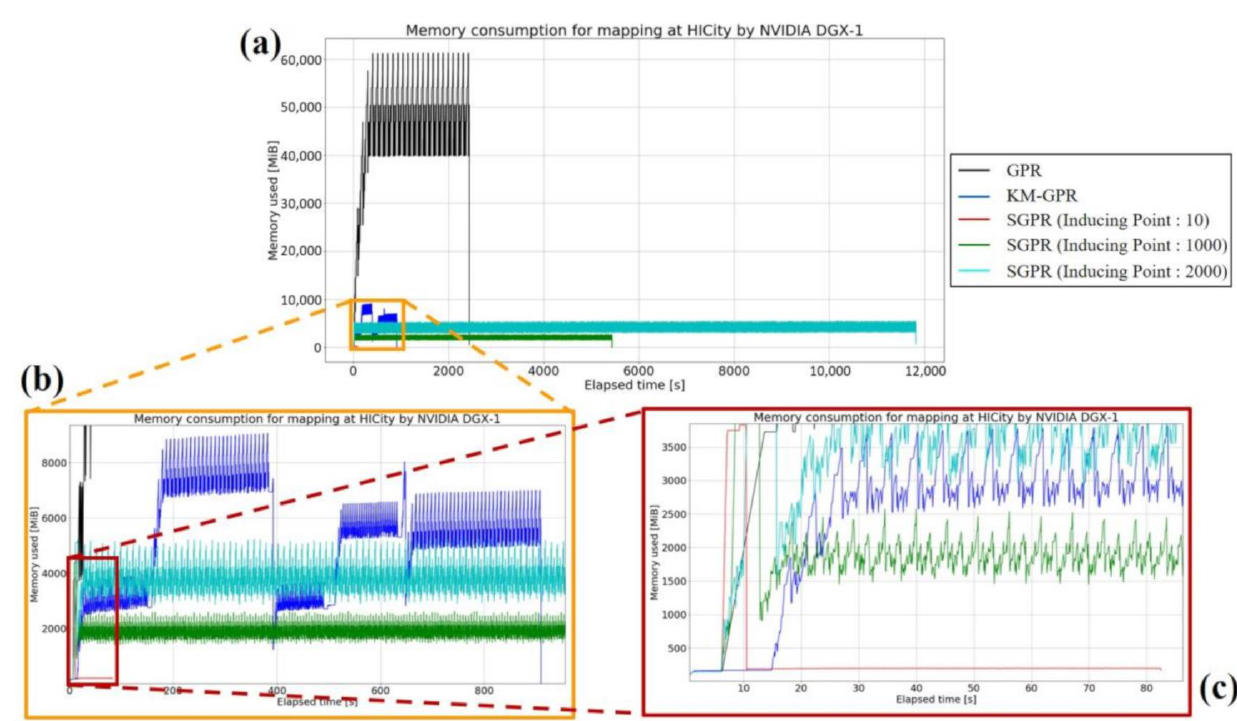
Figure 8. Graph of memory consumption for each method of magnetic mapping in HICity. GPR, KM-GPR, and SGPR with 10, 1K, and 2K inducing points are shown. ( a ) Graph showing all the methods, ( b ) enlarged graph of KM-GPR, and ( c ) enlarged graph of SGPR with 10 inducing